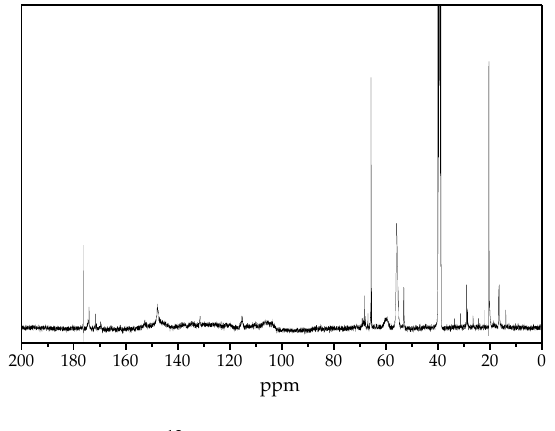
Figure 6. 13 C NMR spectra of DES-Lignin. Table 4. 13 C NMR analysis of DES-Lignin.